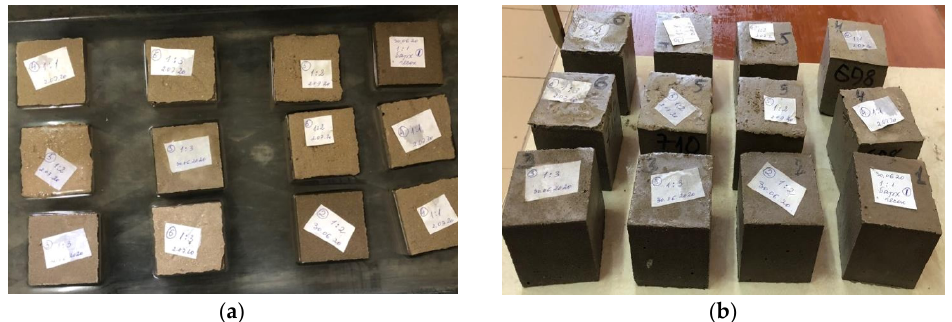
Figure 10. Water absorption test: ( a ) exposure to water, and ( b ) drying and weighing.